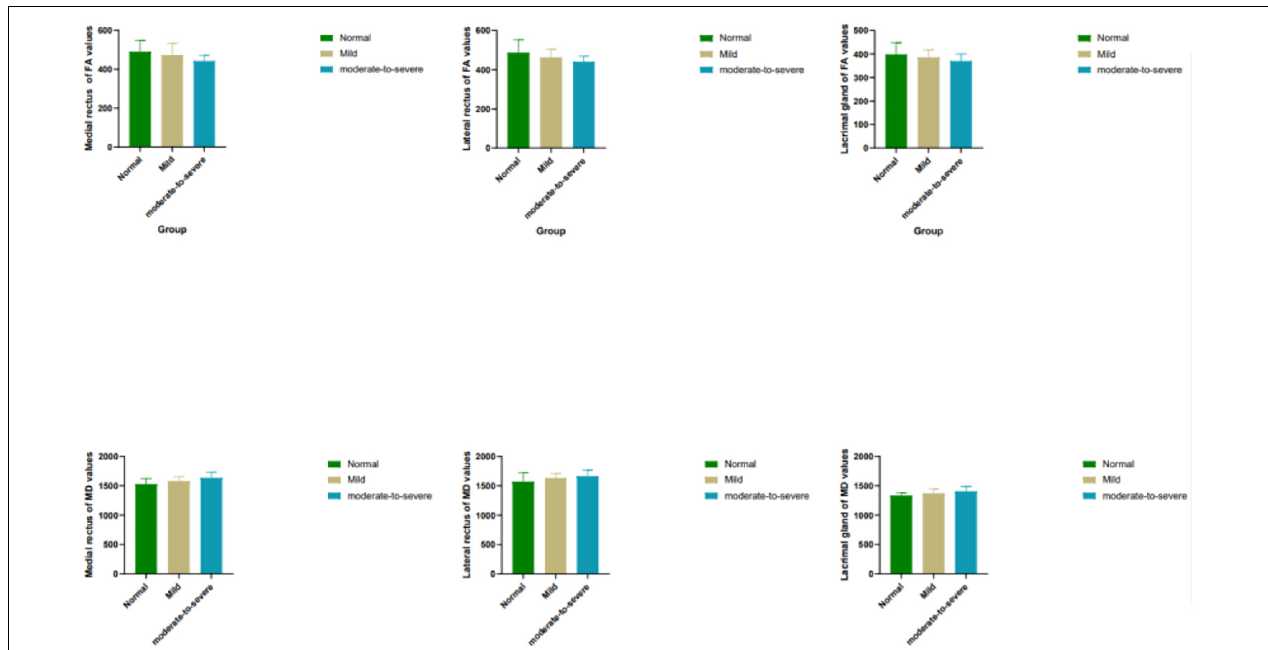
FIGURE 2 | Box plots show comparisons of all DTI parameters in EOMs and LG between groups. Units of MD are × 10 - 6 mm 2 /s. FA, fractional anisotropy; MD, mean diffusivity.